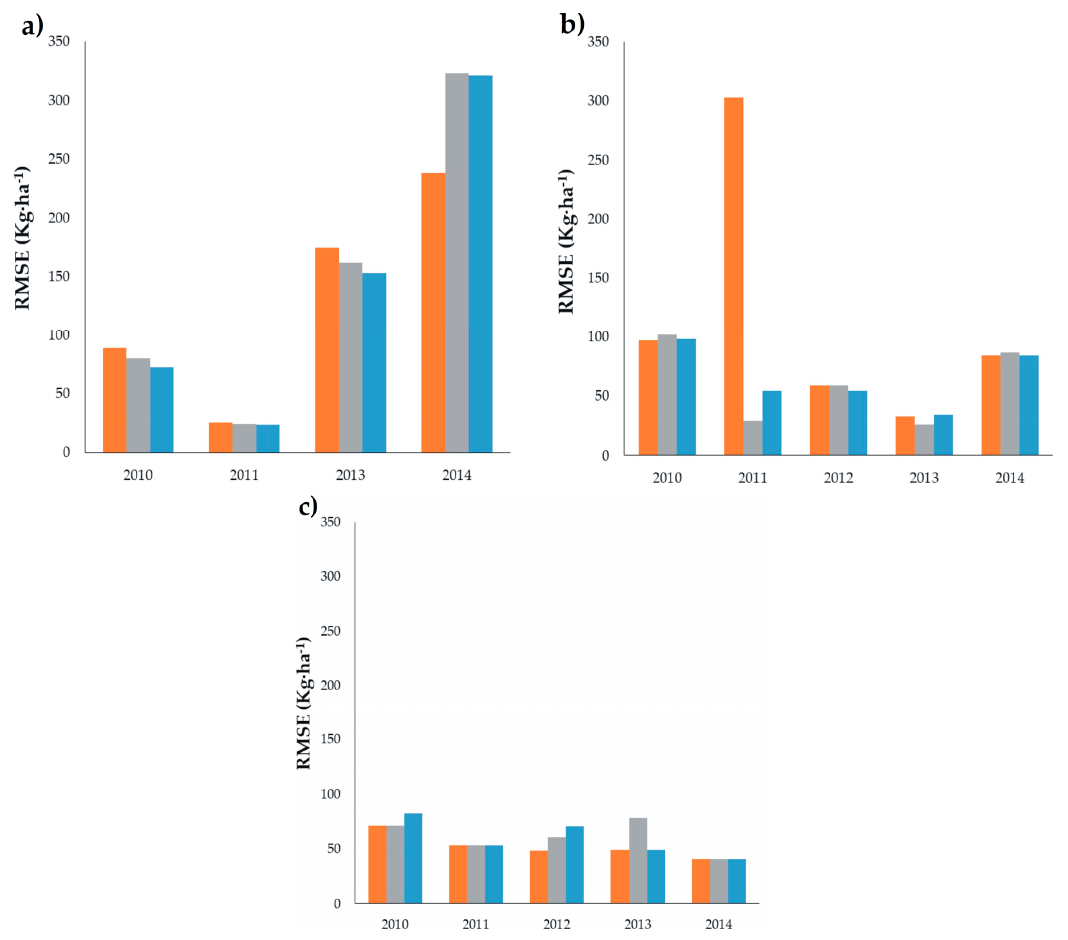
Figure 10. Variation in the precision of the correction methods represented by the RMSE (kg · ha − 1 ). Figure 6. Spectral response of each correction method in Eden for 2010 ( a ); 2011 ( b ); 2013 ( c ); 2014 ( d );